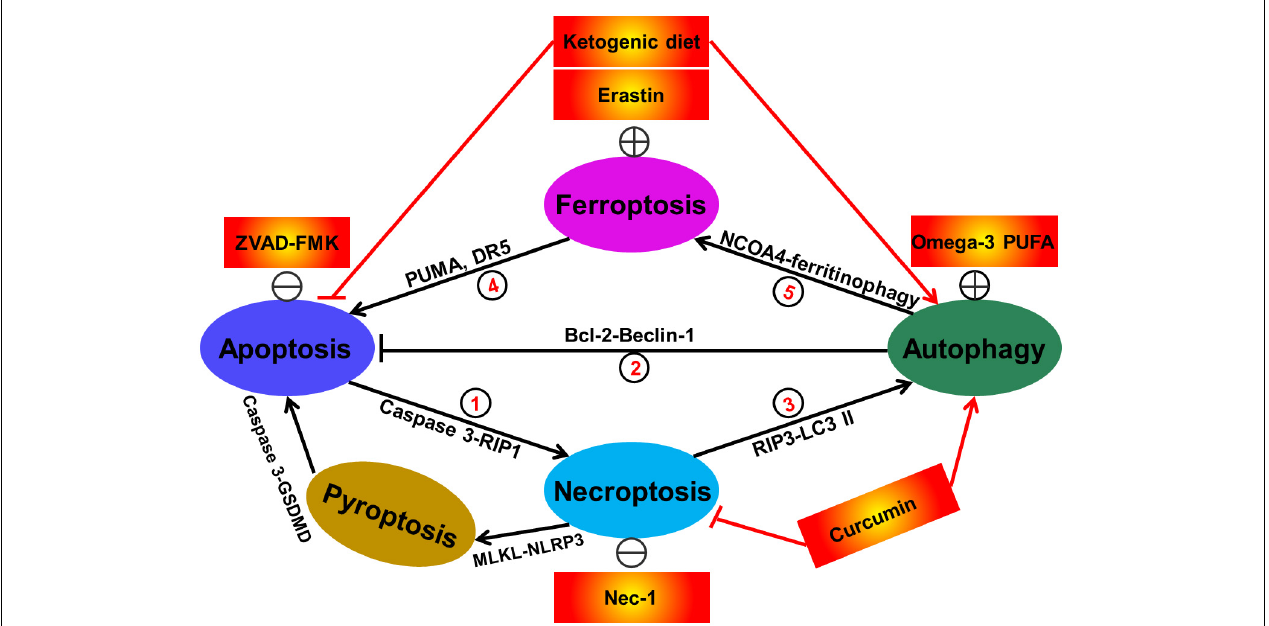
FIGURE 3 | Interactions between different types of redox-related cell death including apoptosis, autophagy, necroptosis, and ferroptosis. Currently, at least seven sorts of crosstalk of redox-regulated cell death have existed in cells. In details, apoptosis induction by caspase-3 activation promotes RIP1-dependent necroptosis. This phenomenon can be reversed by treatment with caspase inhibitor ZVAD-FMK ( (cid:192) ). Activation of autophagic response by increased Beclin-1 has the capacity of abrogating cellular apoptosis. The direct evidence supporting this fact is that administration of omega-3 polyunsaturated fatty acid has obviously attenuated neuronal apoptosis in a rat model of traumatic brain injury via inducing SIRT1-mediated deacetylation of Beclin-1 ( (cid:193) ). Suppression of necroptosis has also been shown to activate autophagic flux. For example, treatment with the necroptosis inhibitor Nec-1 has been demonstrated to alleviate hepatocyte autophagy and subsequently suppress liver damage ( (cid:194) ). Ferroptosis activation by erastin has been reported to trigger cell apoptosis via upregulating apoptosis-relating factors including PUMA and death receptor 5 ( (cid:195) ). Additionally, autophagy has also been illustrated to be a positive regulator of ferroptotic cell death ( (cid:196) ), due to the previous investigations showing that NCOA4 (nuclear receptor coactivator 4)-mediated degradation of ferritin and elevation of intracellular Fe 2 + levels (namely ferritinophagy) contributes to ferroptosis in mouse embryonic fibroblasts. In some cases, some therapeutic interventions including ketogenic diet and curcumin are able to simultaneously regulate diverse cell death modes. The apoptotic executioner caspase-3 specially blocks GSDMD-mediated pyroptosis ( (cid:197) ). The evidence for the contribution of necroptosis to pyroptosis arises from the fact showing that activated MLKL triggers NLRP3-mediated inflammasome formation ( (cid:198)